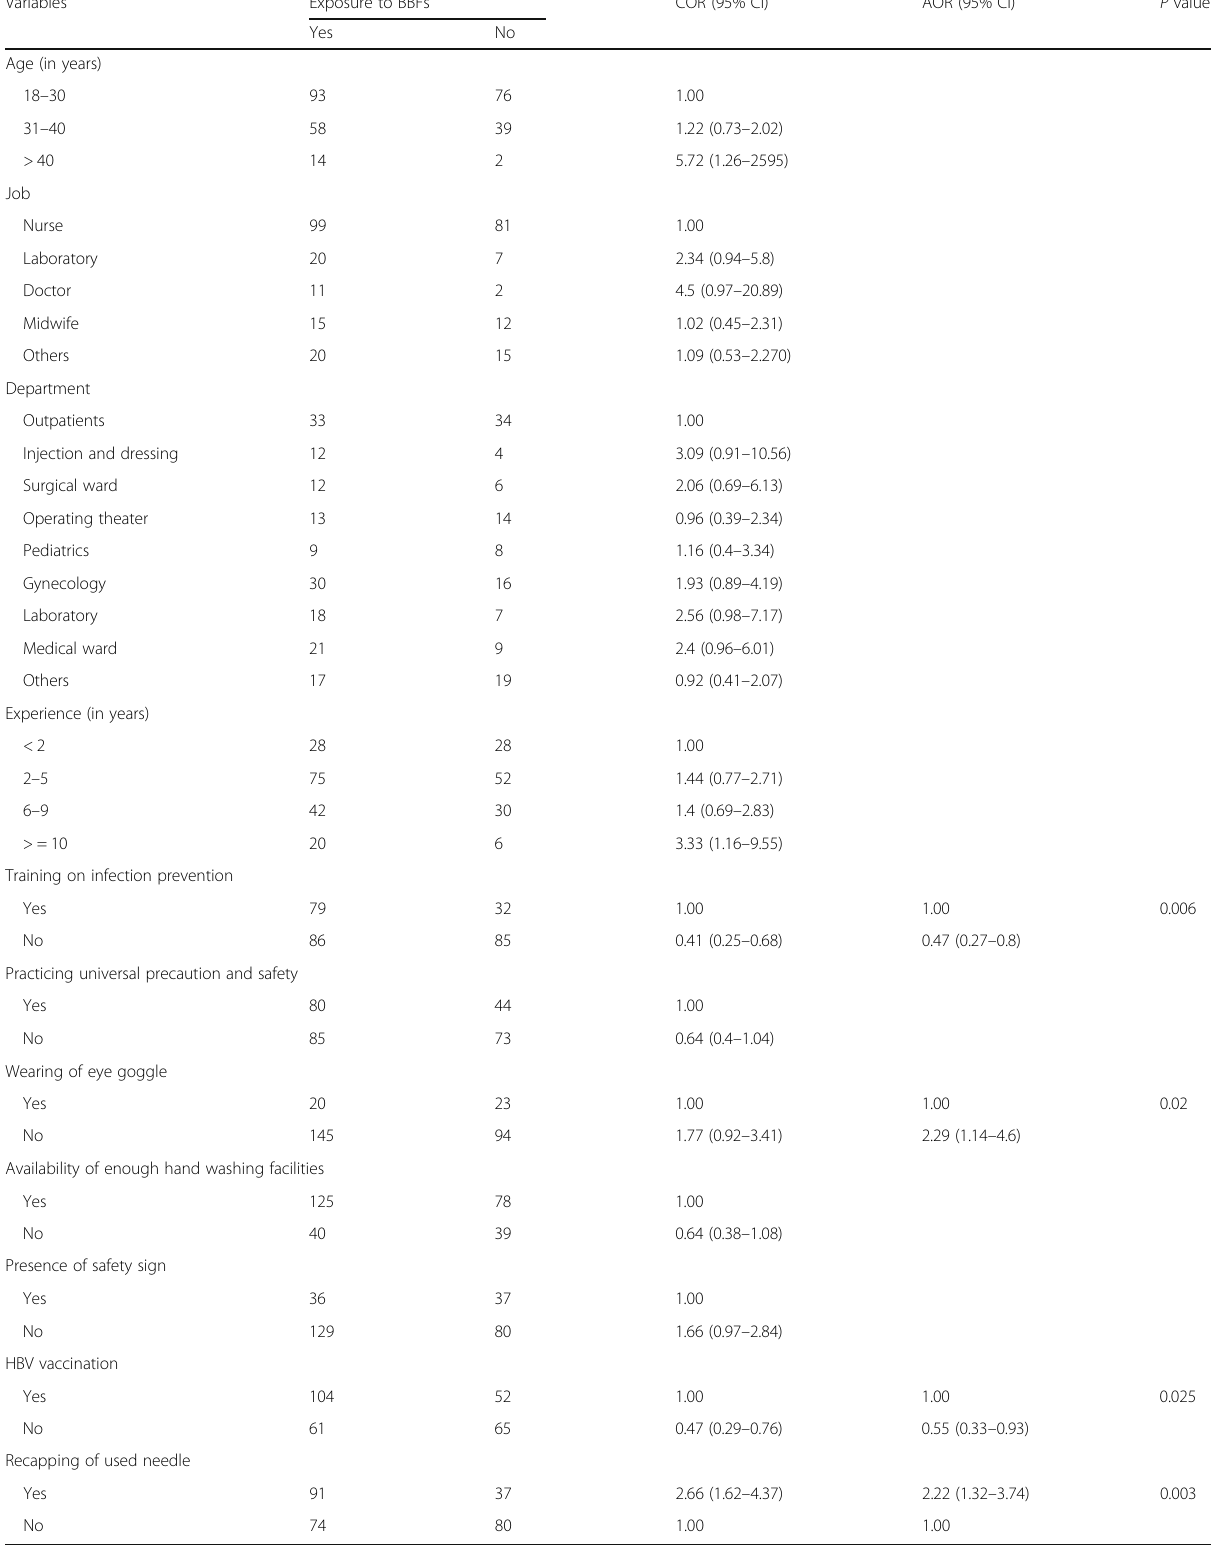
Table 4 Multivariate logistic regression analysis of risk factors associated with blood and body fluids in the past year exposure to blood and body